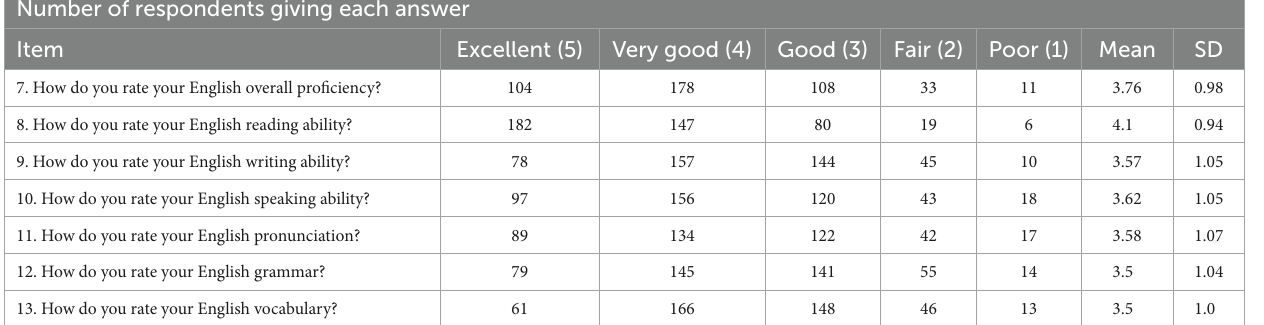
TABLE 2 Self-rated English language proficiency. Number of respondents giving each